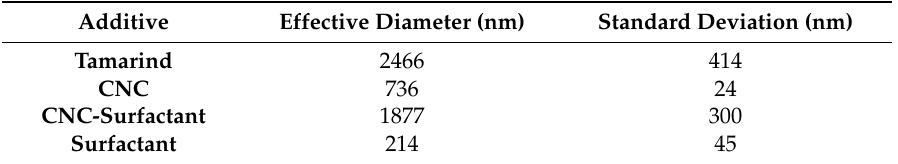
Figure 4. SEM images of: ( a ) Pineapple fibers; ( b ) Tamarind Powder; and ( c , d ) Aloe Vera. Table 2. Size of the additives measured using Dynamic light scattering (DLS).